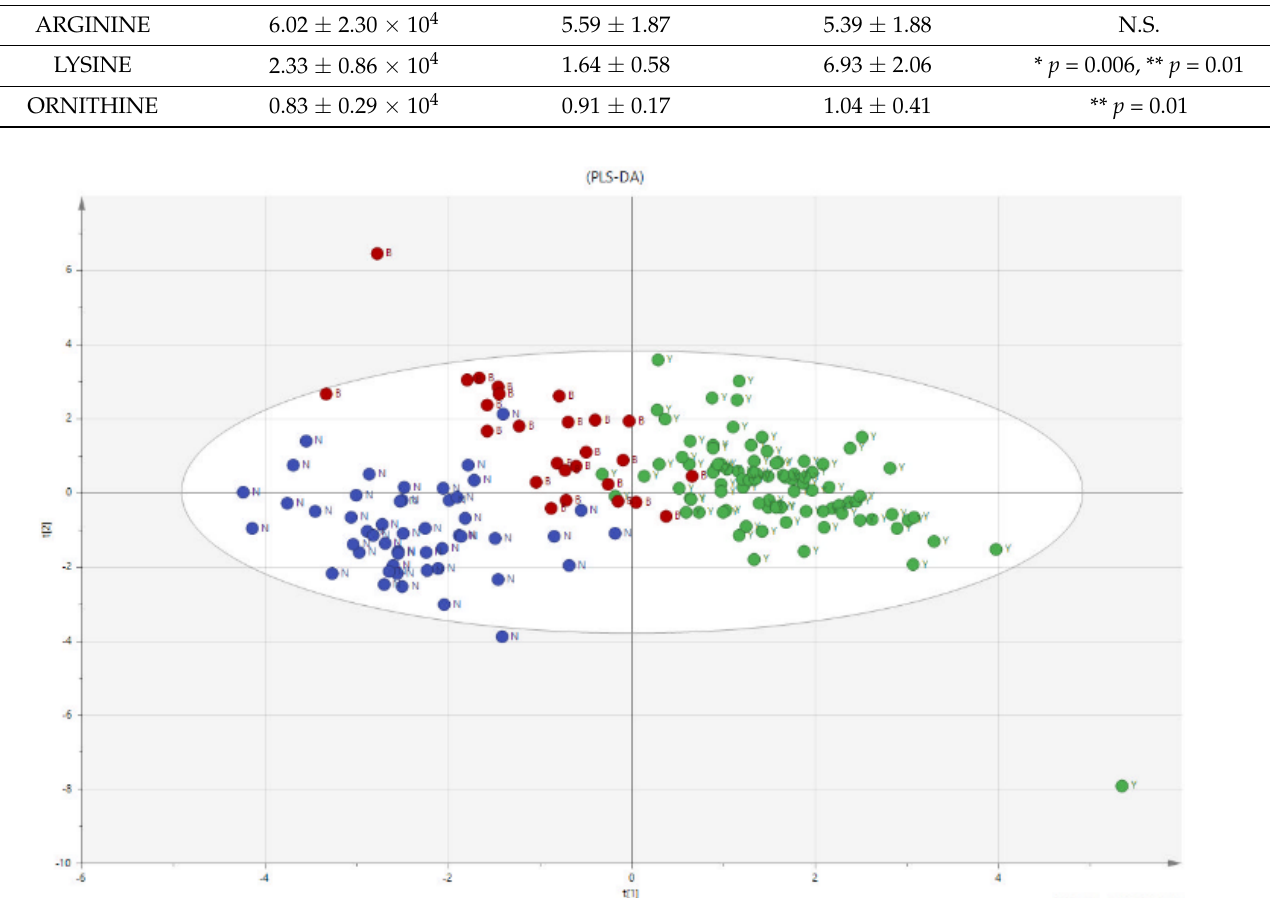
Figure 1. Multivariate analysis using PLS-DA method. PLS-DA loading plot shows a good dis-crimination of the three groups of samples, PC (GREEN), the PL group (RED) and the BPH group (BLUE).